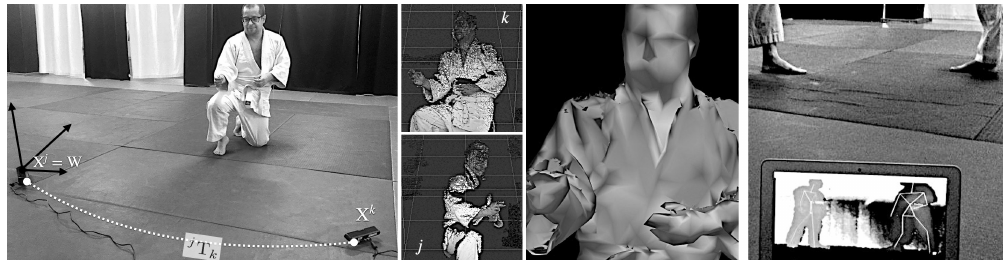
Figure 5. Leftmost images: Two spatially registered depth sensors of ASUS and Microsoft, respectively—corresponding point clouds as measured from both devices and low-quality textured-mesh isosurface reconstruction. Rightmost image: OpenNI-compatible sensor (placed behind the laptop’s screen and not visible in the photographs) that track the movement of two aikido practitioners ( shomen-uchi kotegaeshi ). Their skeletons are derived in real-time and appear in the laptop’s screen. Images correspond to one of the co-authors of the paper and were obtained at Judelda dojo (Elda,